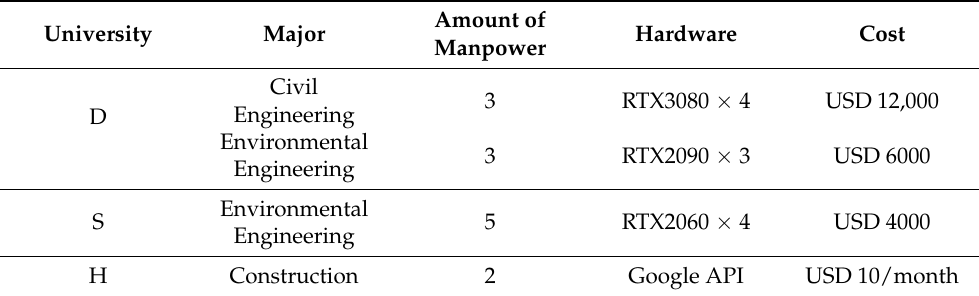
Table 1. Status and cost of AI research equipment for architectural and civil engineering studies at universities in South Korea (2020). Amount of University Major Hardware Cost Manpower Civil Engineering D Environmental Engineering Environmental Engineering H Construction 2 Google API USD